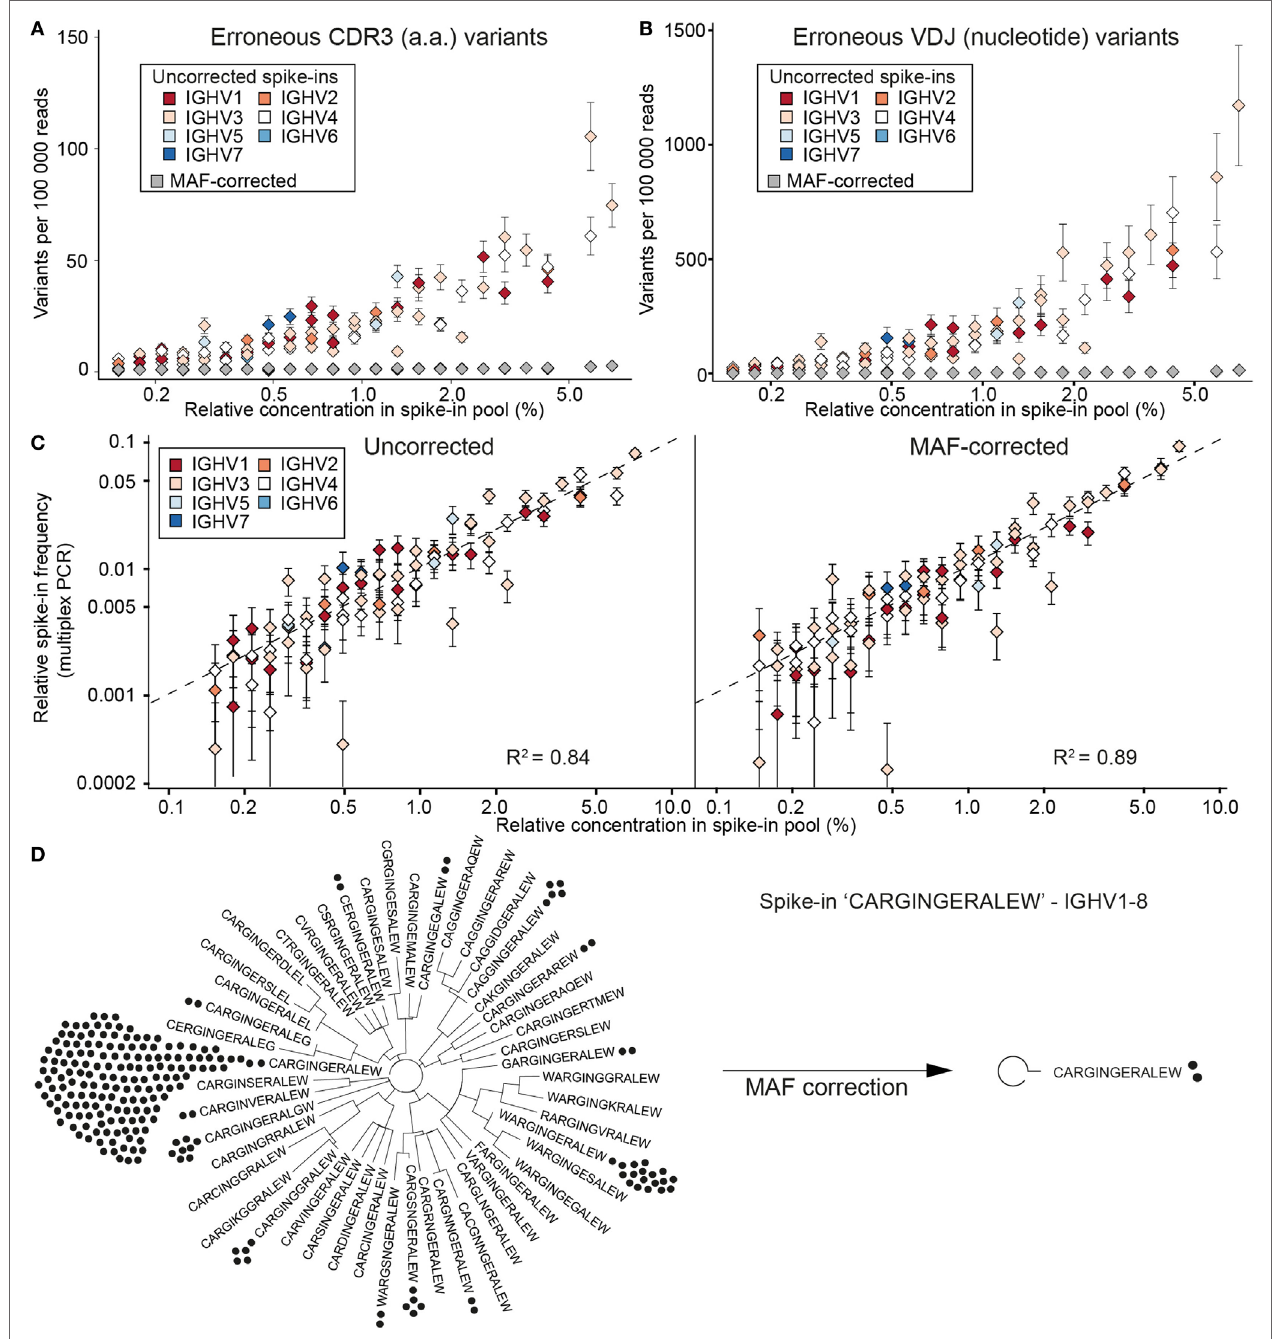
FIgURe 3 | Synthetic standards used to evaluate error and bias correction of Ig-seq data by molecular amplification fingerprinting (MAF). (A) The number of erroneous complementarity determining region 3 (CDR3) sequences ( ≤ 1 a.a. difference from the correct CDR3) per 100,000 reads is plotted against the relative concentration of each standard in a master stock. Color-coded diamonds, germline IGHV segment family of the respective standard and number of erroneous variants in uncorrected (raw) data; gray diamonds, number of variants remaining after MAF error correction. (B) The number of erroneous VDJ variants derived from each standard was calculated by finding all variants that carried the correct CDR3 a.a. sequence, but differed by ≤ 1 nt across the entire VDJ region. Colored diamonds, uncorrected data; gray diamonds, variants remaining after MAF error correction. (c) Sequencing bias introduced by multiplex-PCR using the framework region 1 (FR1) primer set was assessed by plotting the measured frequencies of each standard against its relative concentration in the master stock. Dashed line represents a bias-free ideal scenario ( R 2 = 1). Left and right plots show observed frequencies pre- and post-MAF bias correction, respectively. (D) Phylogenetic trees visualizing the CDR3 a.a. variants present for a selected standard with the CDR3 a.a. sequence CARGINGERALEW using IGHV1-8 and IGHJ1. Prior to error correction, 39 erroneous CDR3 a.a. variants (branches) and 218 VDJ nt variants (black circles) were observed. Following MAF error correction, only the original correct CDR3 a.a. (two VDJ nt variants) remain. Ig-seq datasets for panels (A–c) consisted of ≈3 × 10 5 preprocessed full-length antibody reads from the synthetic spike-in only samples; dataset IgG1_D1 was used for panel (D) (see Table S3 in Supplementary